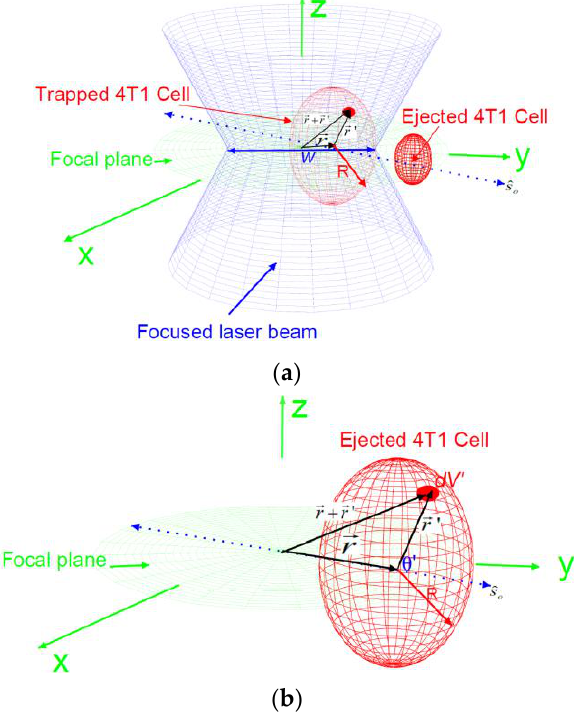
Figure 2. ( a ) The blue double cone is a schematic for a focused linearly polarized laser beam along the direction 𝑠̂ 𝑜 on the x – y plane and propagating in the z-direction. This beam has a diameter of 2w at the trap location. The red sphere represents a 4T1 cell before ejection (big) and after ejection (small). The vector 𝑟⃗ is the position of the center of the cell as measured from the center of the trap; 𝑟⃗ ′ is the position of an infinitesimal free charge, 𝑑𝑞′ , from the center of the cell. ( b ) A schematic for the position at a given instant in time for an ionized and ejected 4T1 cell along the direction of polarization 𝑠̂ 0 ; 𝜃 is the angle between the polarization direction and the vector 𝑟⃗ ′ .